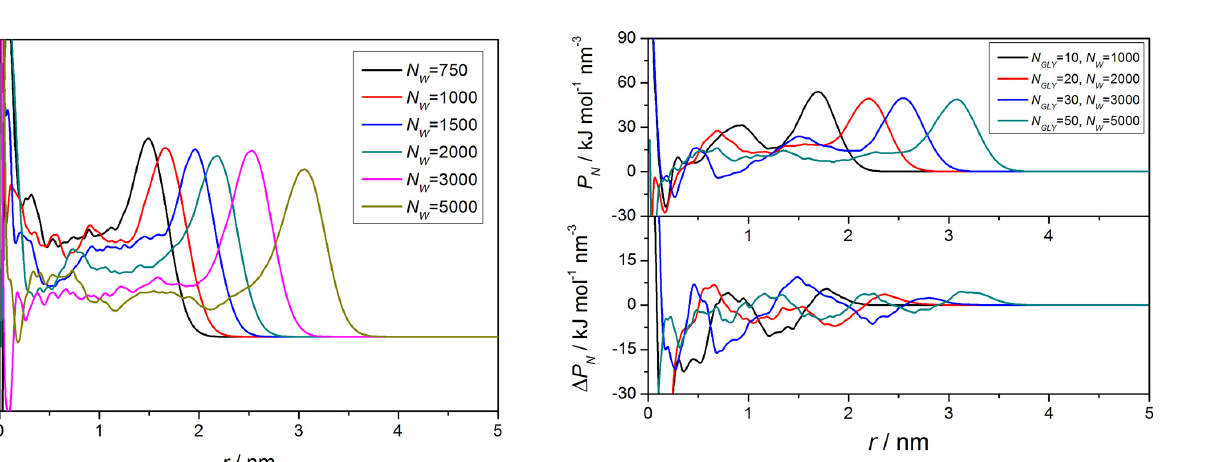
Fig. 2. Normal component of the Irving-Kirkwood pressure tensor in systems 1–6.